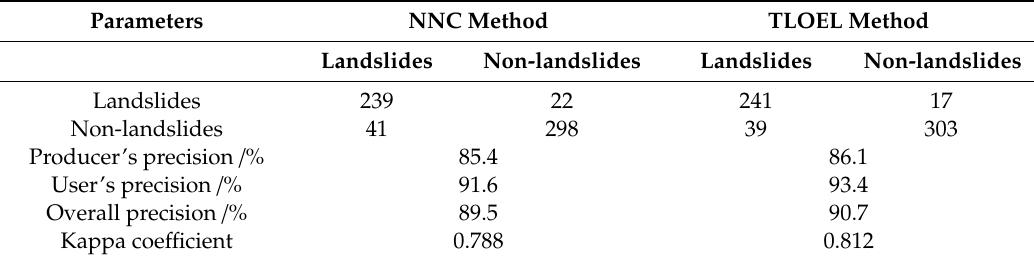
Table 4. Confusion matrix of experimental image 1.